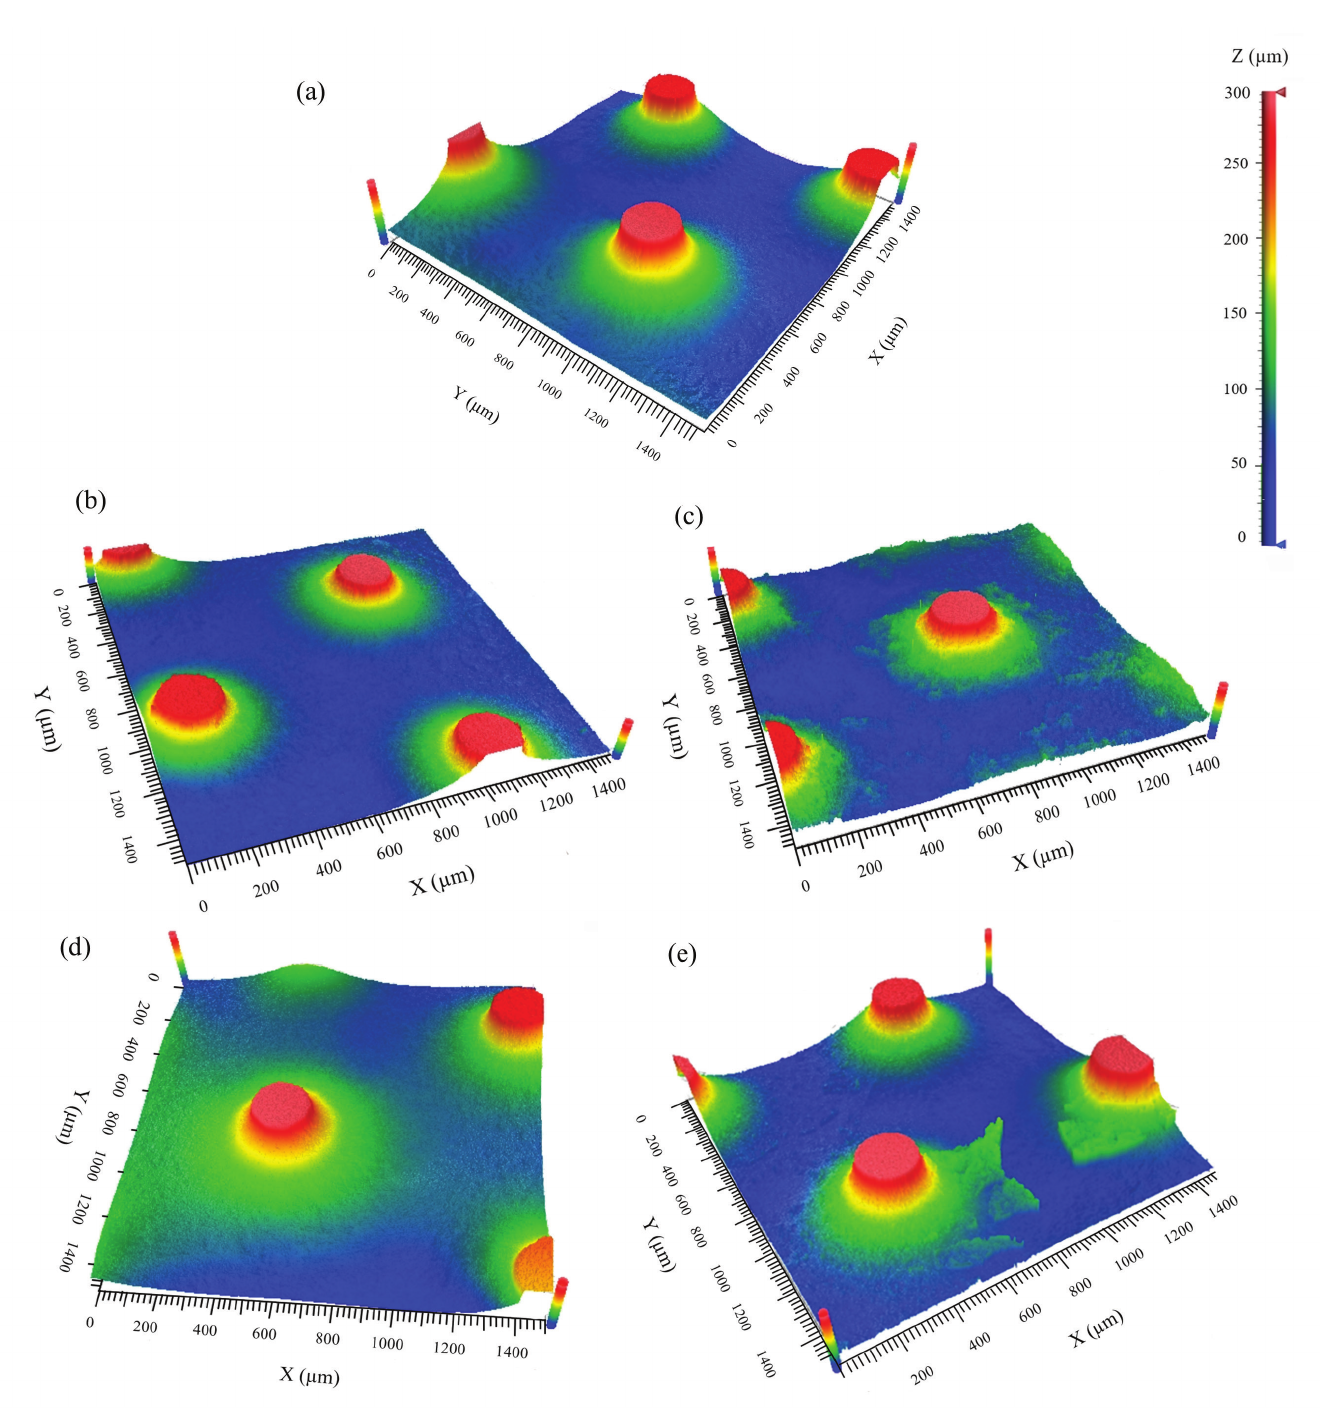
Fig. 4 – 3D optical images of different catalysts on catalyst plate: (a) blank catalyst plate, (b) Pd/Al (d)